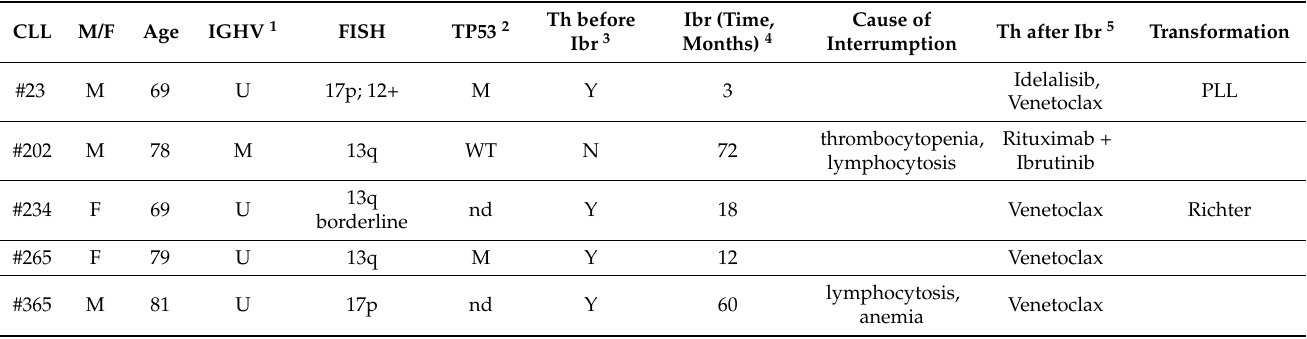
Table 1. Ibrutinib-resistant patients’